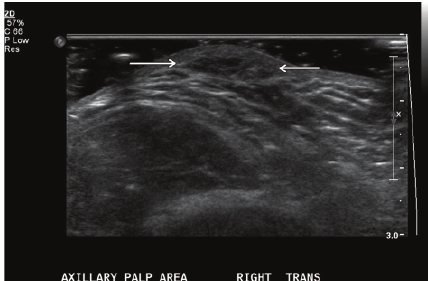
Figure 1: Representative ultrasound imaging of the right axilla demonstrates the area of palpable abnormality an approximately 1.2cm oval, hypoechoic solid-appearing lesion. No capsule or posterior acoustic enhancement was evident. No vascularity was identified within the lesion on color Doppler interrogation and the adjacent vessels within the axilla were compressible and patent.